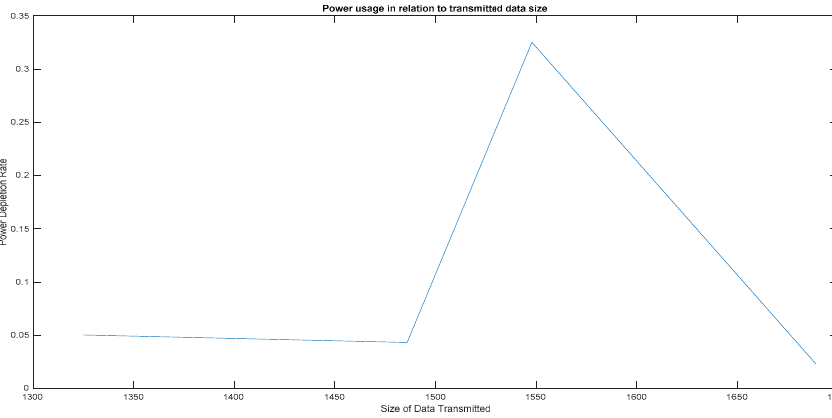
Figure 4. A graph of response time vs. packet count in a state of zero power.